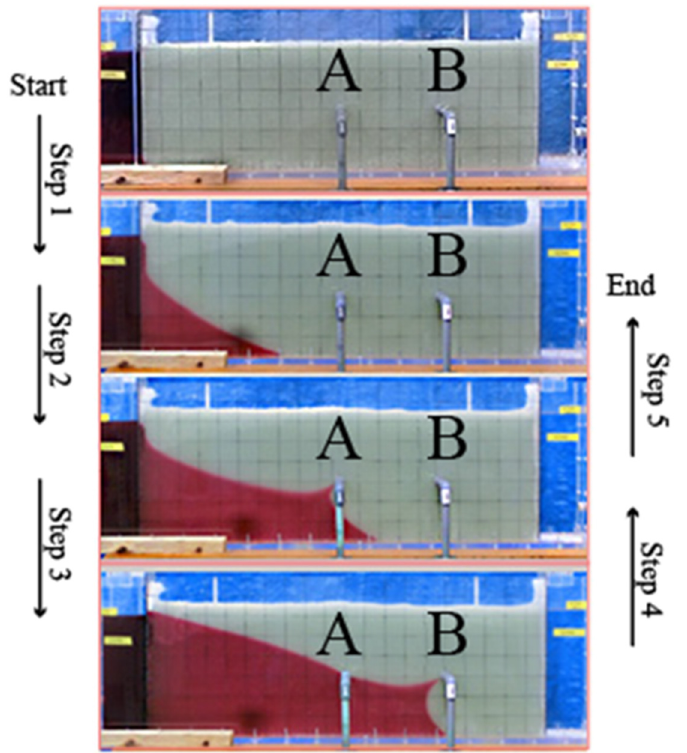
Figure 3. Experimental procedure, showing the intrusion process for pumping ratio of 2.6 as an example. Table 1. Experimental parameters. Hydraulic conductivities, pumping rates at Wells A and B, and pumping ratios.